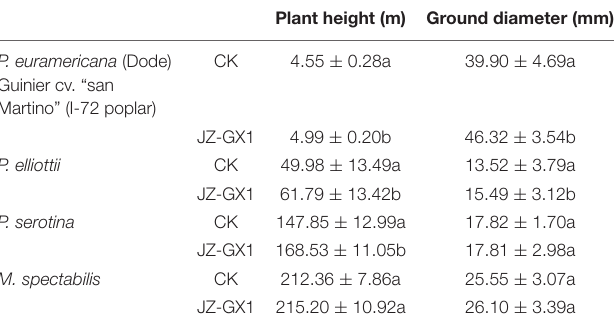
TABLE 4 | Growth-promoting effect of Rahnella victoriana JZ-GX1 on different